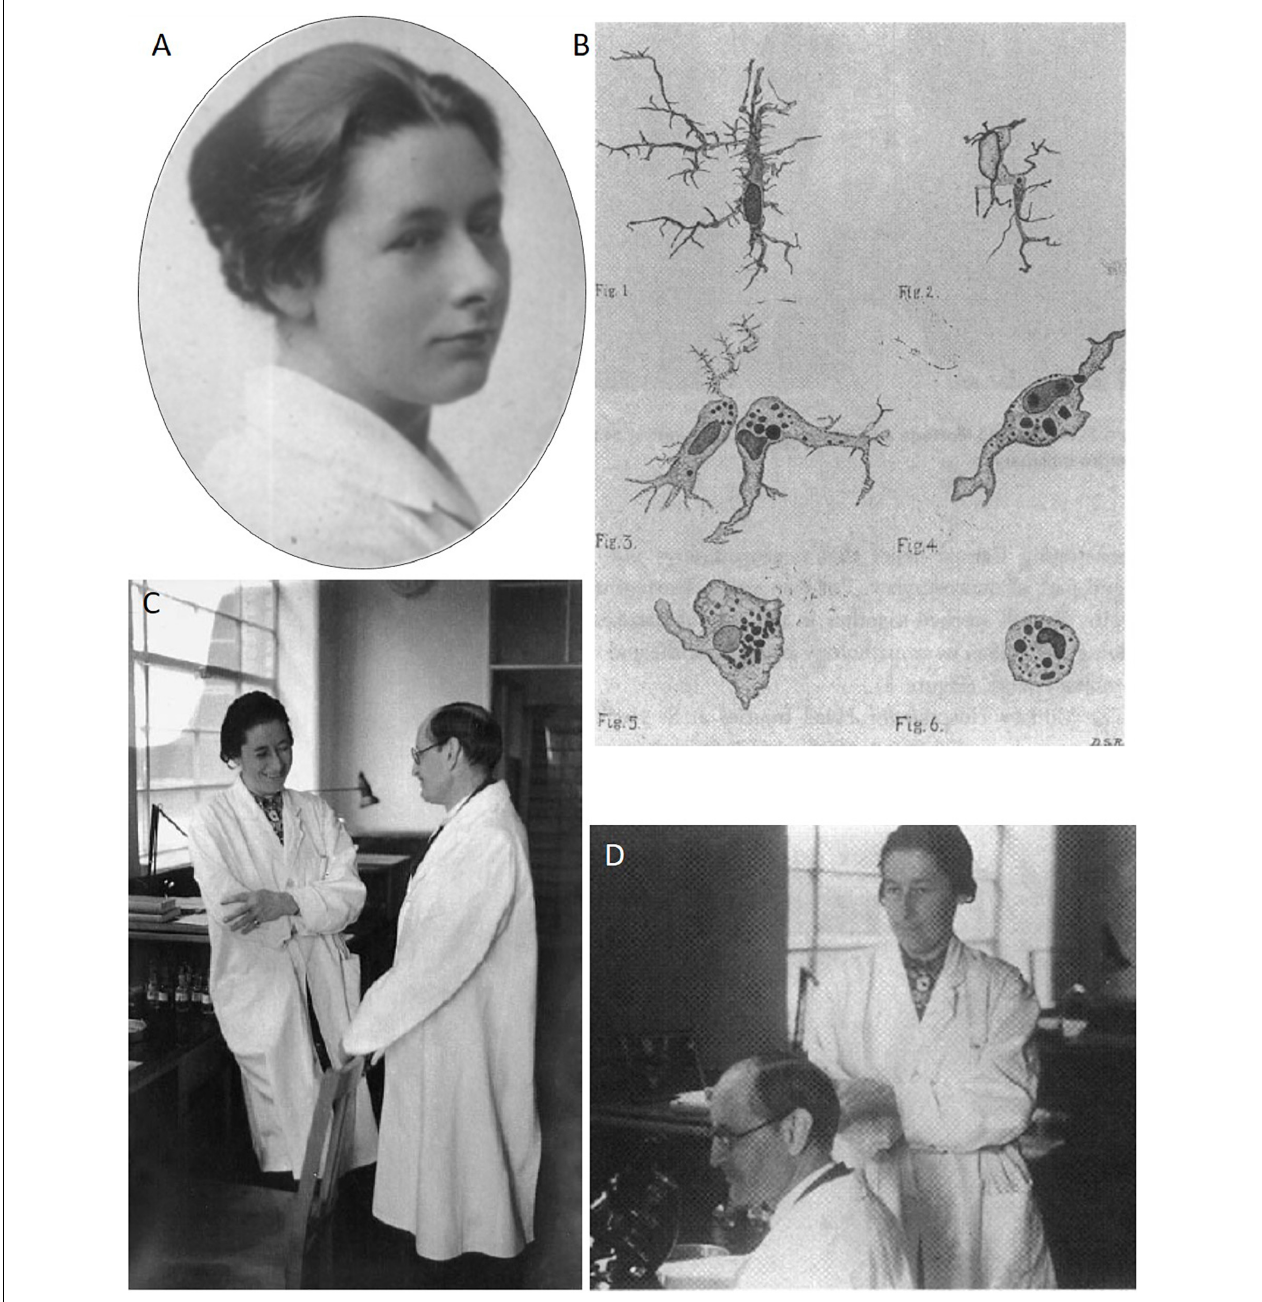
FIGURE 2 | Dr. Dorothy Russell. (A) Young Dorothy Russell circa 1919, while studying at The London Royal Hospital (taken from Women at Queen Mary Exhibition Online). (B) Original drawing of microglial and macrophage cells done by Dorothy Russell at Wilder Penfield’s laboratory and published in Russell (1929). (C,D) Dorothy Russell and Pío del Río-Hortega at the latter’s laboratory at the University of Oxford